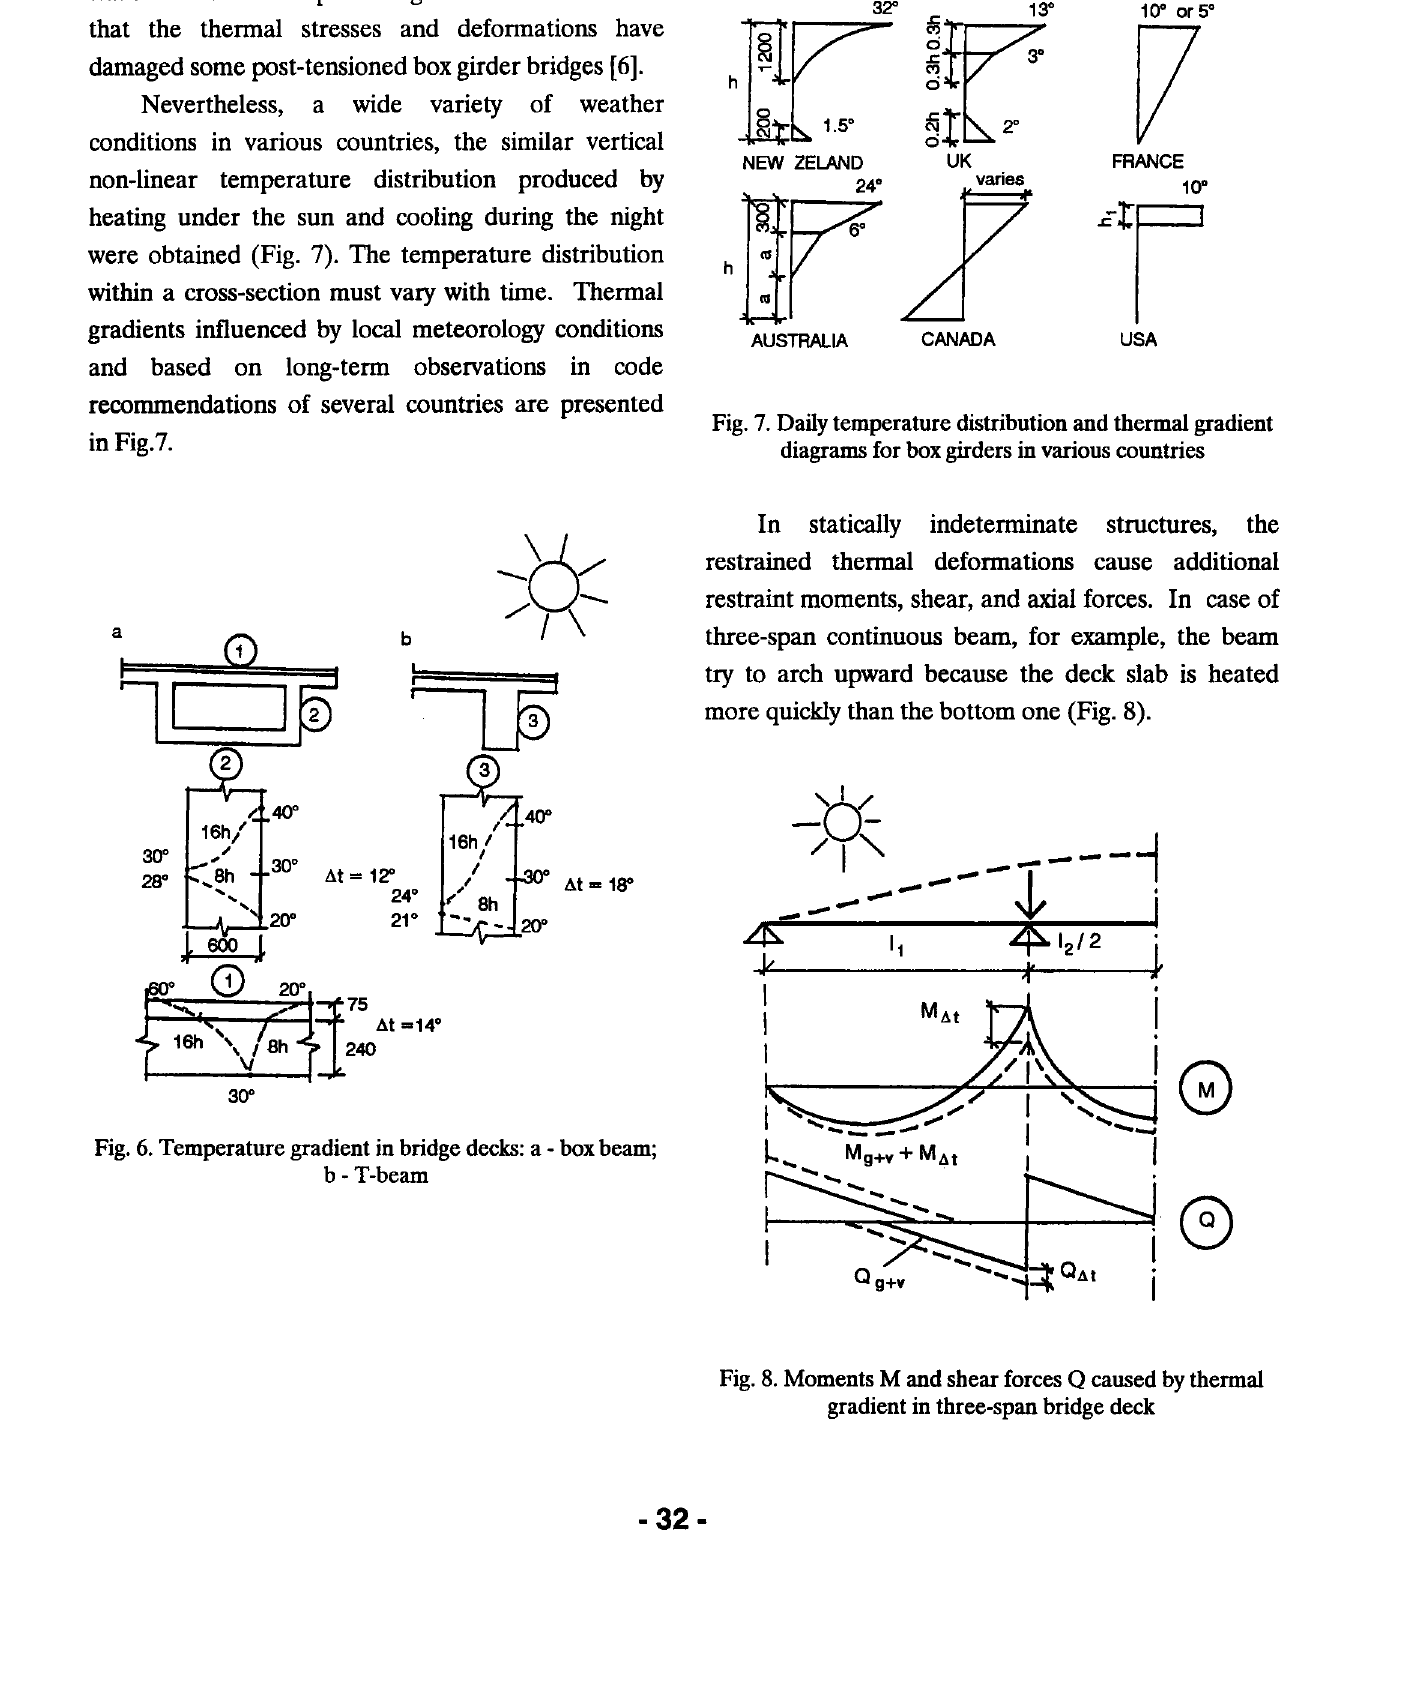
Fig. 8. Moments M and shear forces Q caused by thermal gradient in three-span bridge